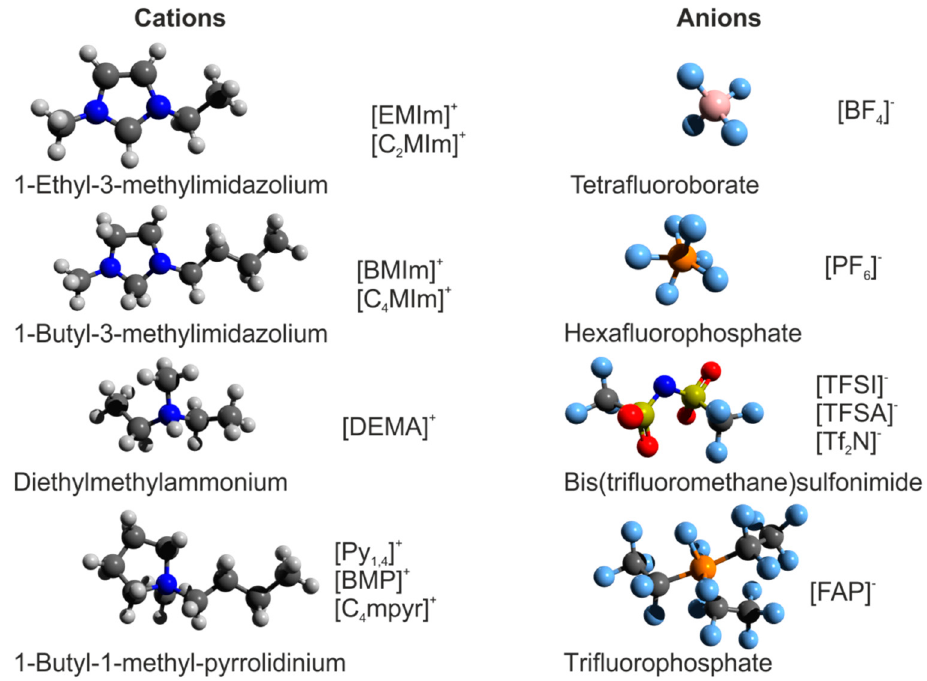
Figure 1. Ball-and-stick models of selected popular ionic liquid cations and anions. Note: A variety of abbreviations for the very same ions are used in the literature.